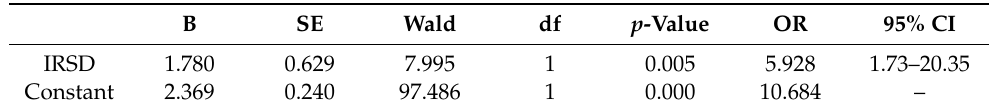
Table 3. Results of logistic regression analysis using model of best fit to analyse the index of relative socio-economic disadvantage (IRSD).